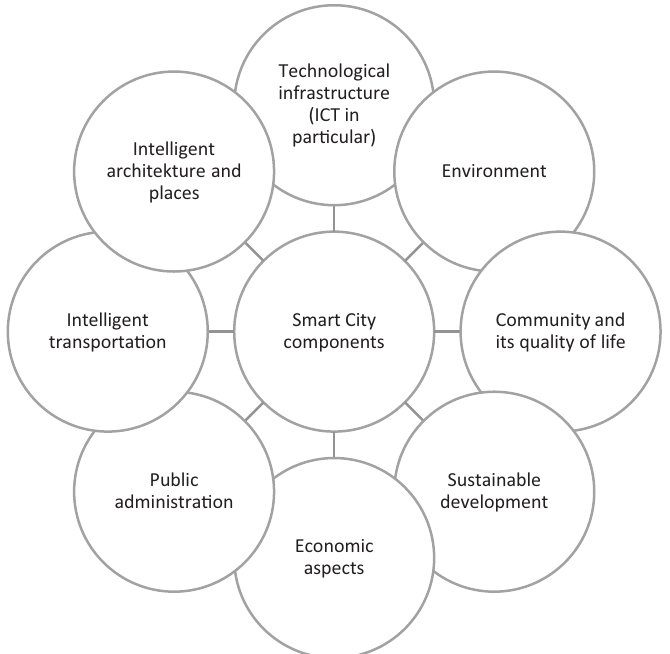
Figure 1. Diagram of smart city components based on the abovementioned definitions (source: created by